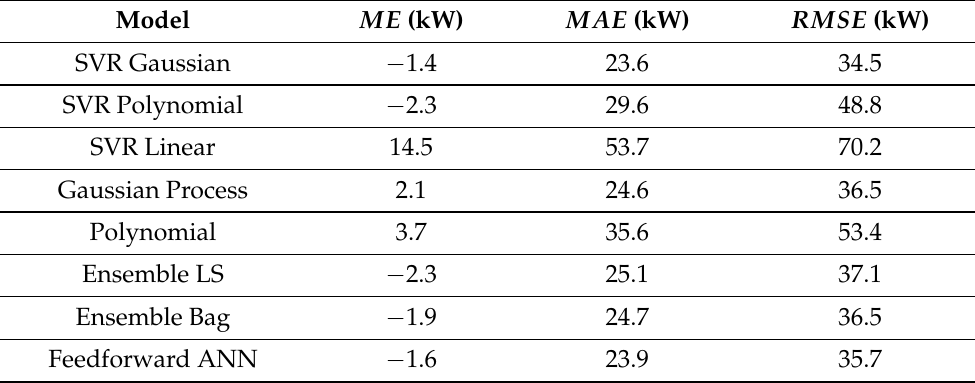
Table 4. Error metrics for testing of different model types for the rotor speed–power regression in Region 2: WF1, average of the wind